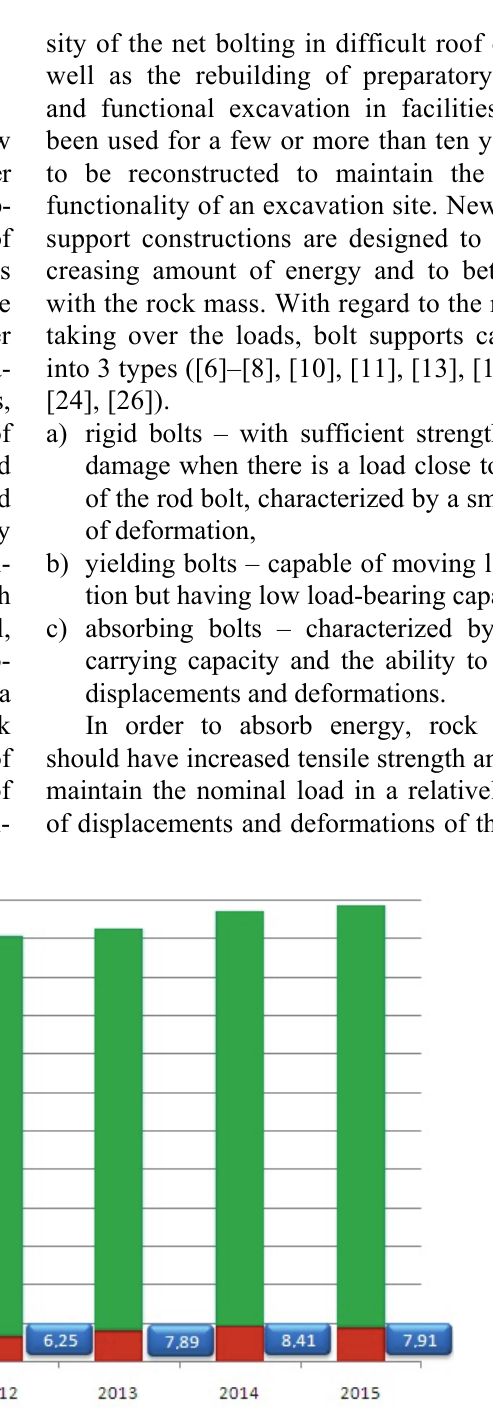
number of built rock bolt supports rock bolt supports used for reconstruction – percentage of rock bolts used for reconstruction in relation to the total number of rock Fig. 1. Number of built rock bolt supports in the Polkowice–Sieroszowice copper mine